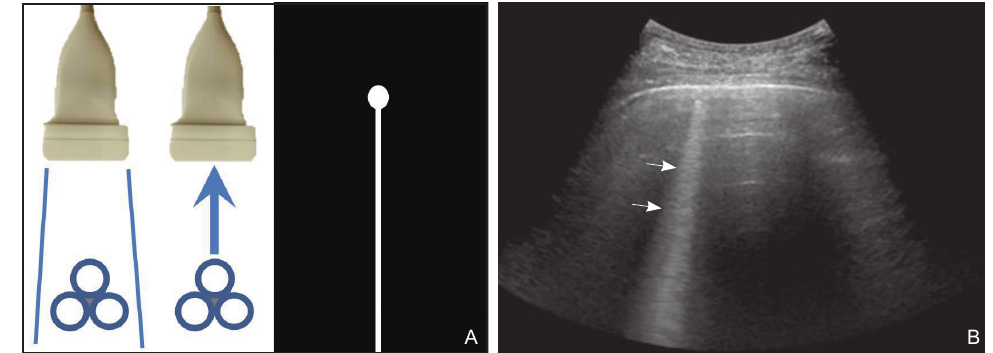
A B Figure 4 Ringing artifacts. (A) Schematic diagram of ultrasonic waves generating strong oscillations between gas-wrapped liquids, which generate continuous echoes and are received by the probe; (B) Bubbles in the alveoli are oscillated and received by the probe under ultrasound excitation, and the acoustic image is formed with the pleura line and laser beam-like strong echo, B-line (arrow).